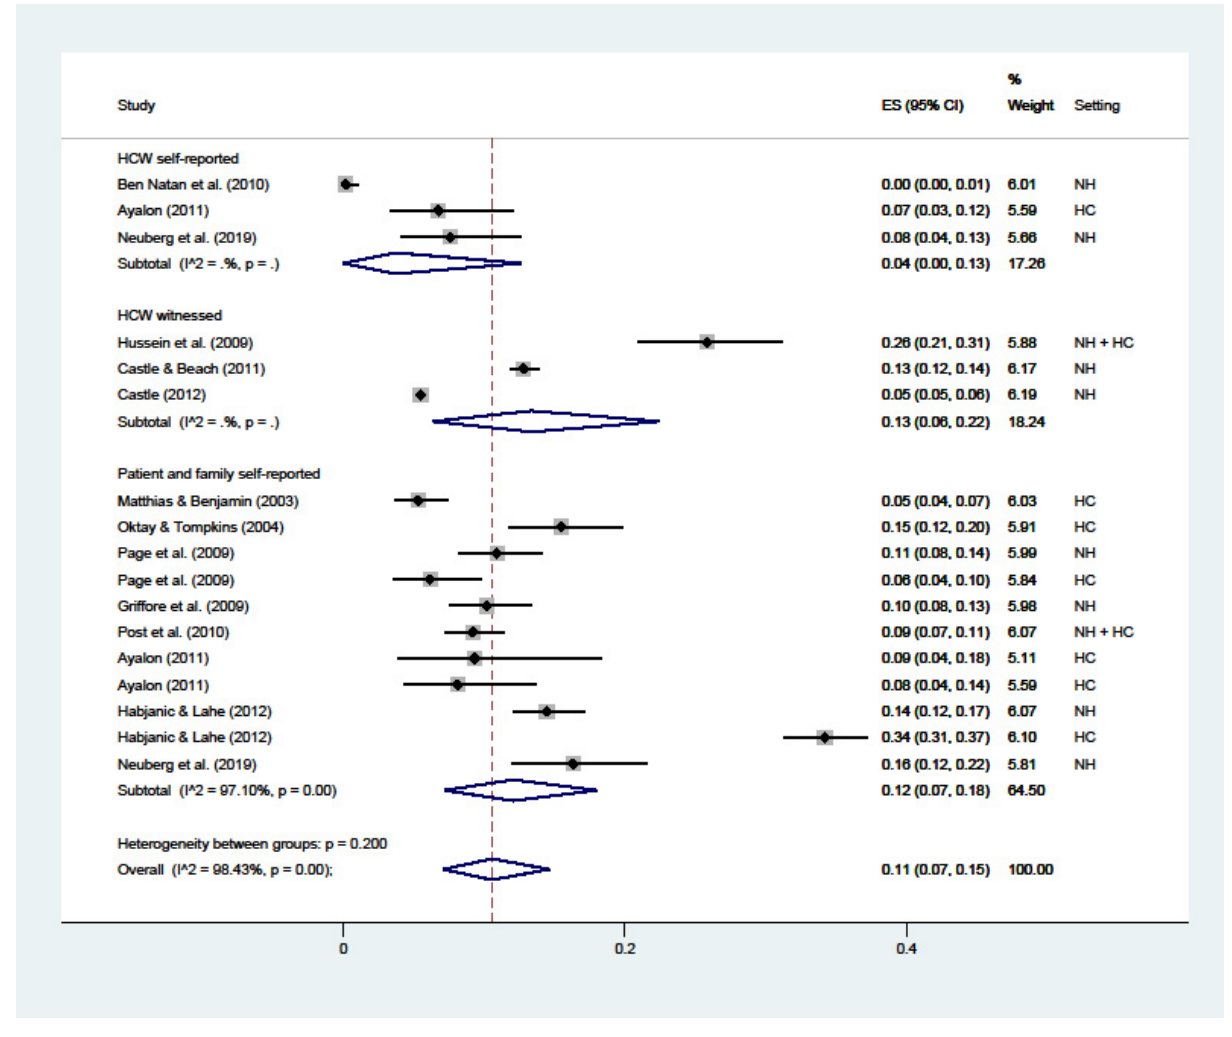
Figure 8. Forest plot of the prevalence of financial abuse in LTC. Subgroup meta-analyses by (Healthcare workers (HCW) self-reported, HCW witnessed, or patient and family self-reported). NH: nursing home; HC: home care.